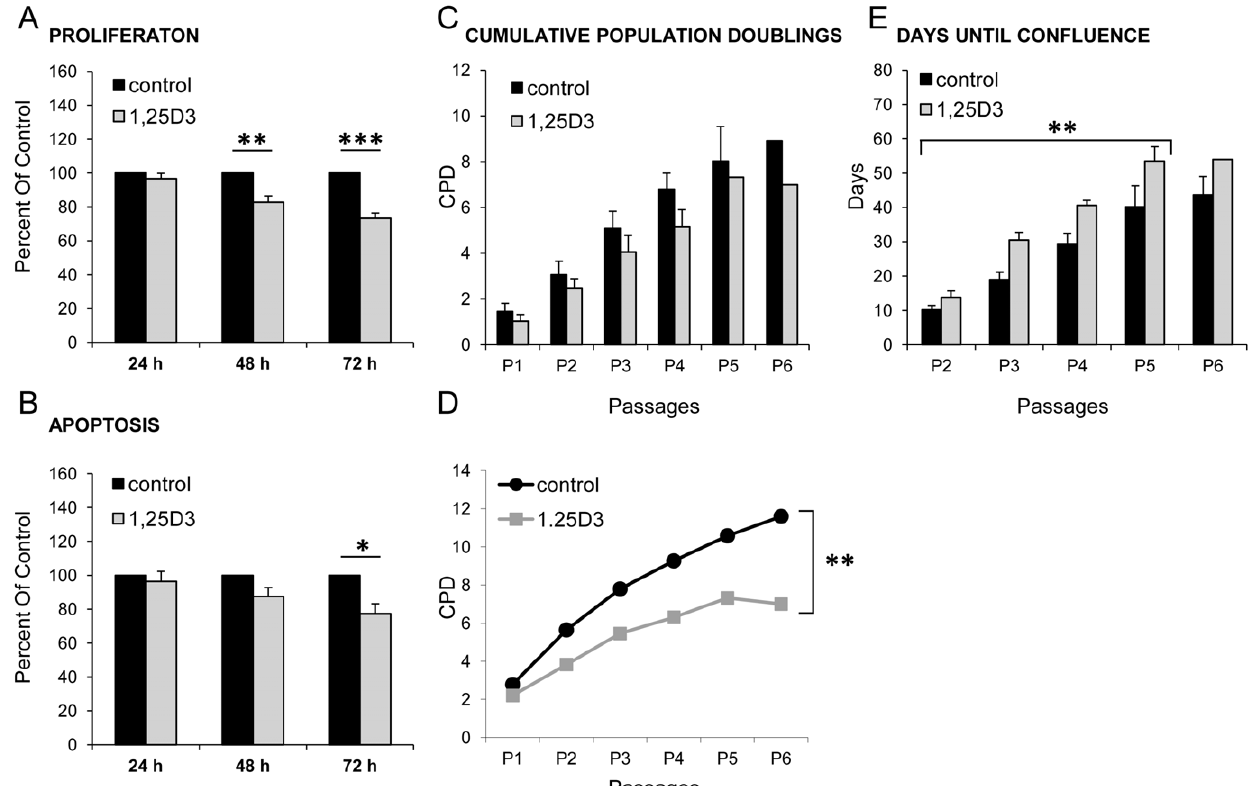
Figure 2. 1,25D3 effects on proliferation, apoptosis and cumulative population doublings. A/B Measurement of proliferation capacity and apoptosis induction of hMSC from three different donors after stimulation with 1,25D3 for 24, 48 and 72 h. The proliferation rate was decreased time-dependently after 1,25D3 treatment (gray bars) compared to control cells (black bars), with significant effects after 48 h and 72 h (A). 1,25D3 stimulation showed the strongest reduction of apoptosis rates after 72 h 1,25D3 treatment (gray bars) compared to control cells (black bars, B).